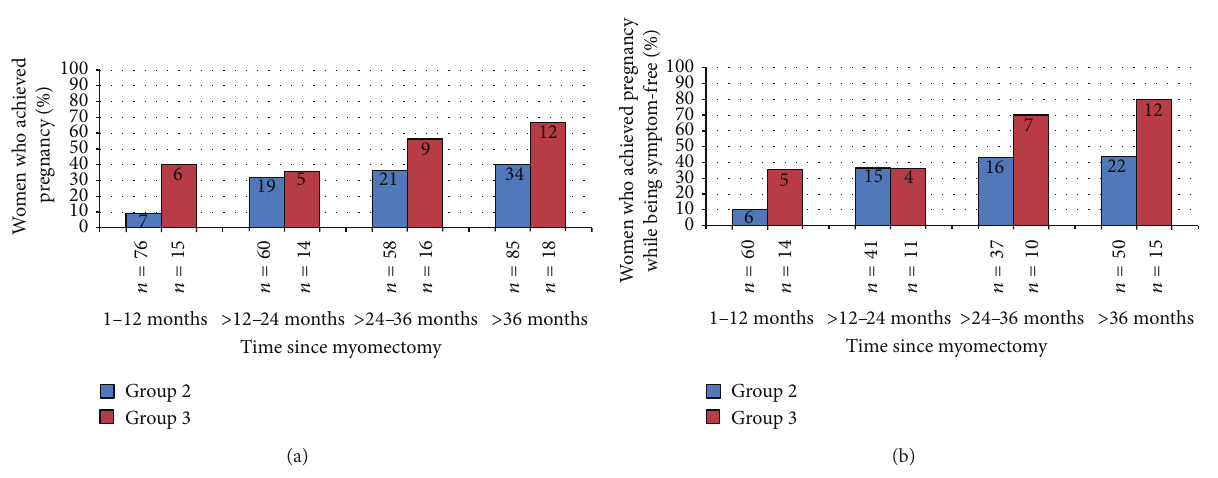
Figure 3: Pregnancy status after myomectomy in women who desired pregnancy, by group and time between myomectomy and survey. Group 2 (blue bars) desired to treat symptoms and preserve ability to get pregnant in the future; group 3 (red bars) desired to improve current chance of pregnancy after myomectomy. 𝑁 in bars is the number of women who became pregnant; 𝑁 below the bars is the total number of women in that group and time period. (a) All women and (b) women who were symptom-free.